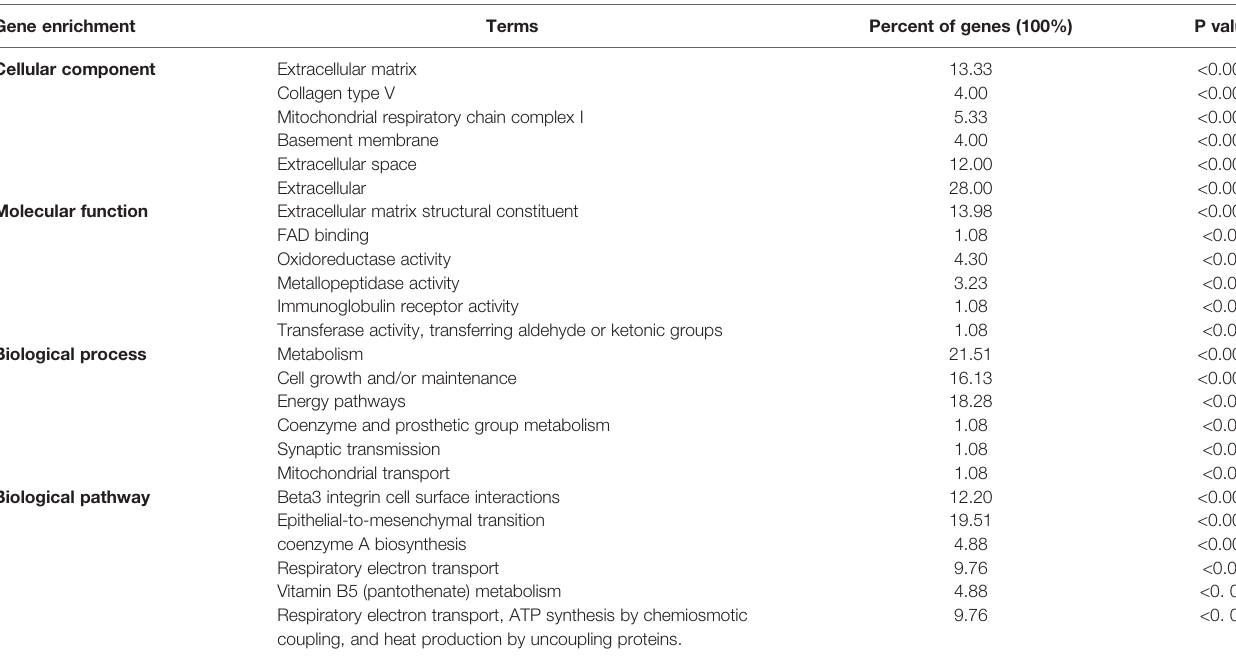
TABLE 4 | Functional enrichment